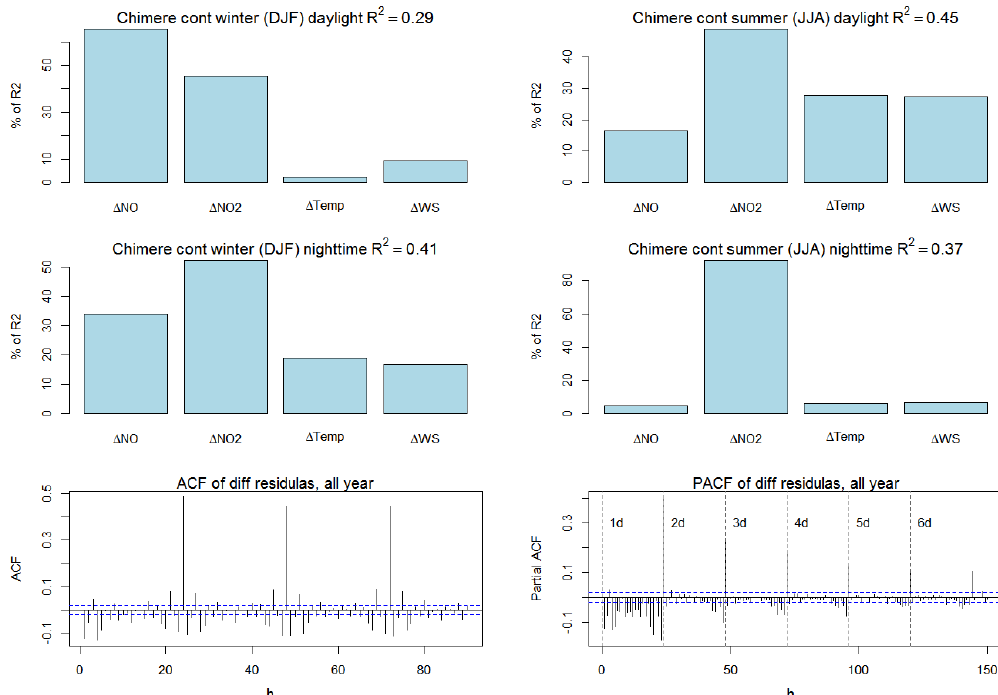
Figure 28. Same as Fig. 27 for EU. The analysis encompasses 61 co-located stations (the EU stations for ozone, NO, NO 2 , WS, and Temp that fall in a radius of 1000m and vertical displacement less than